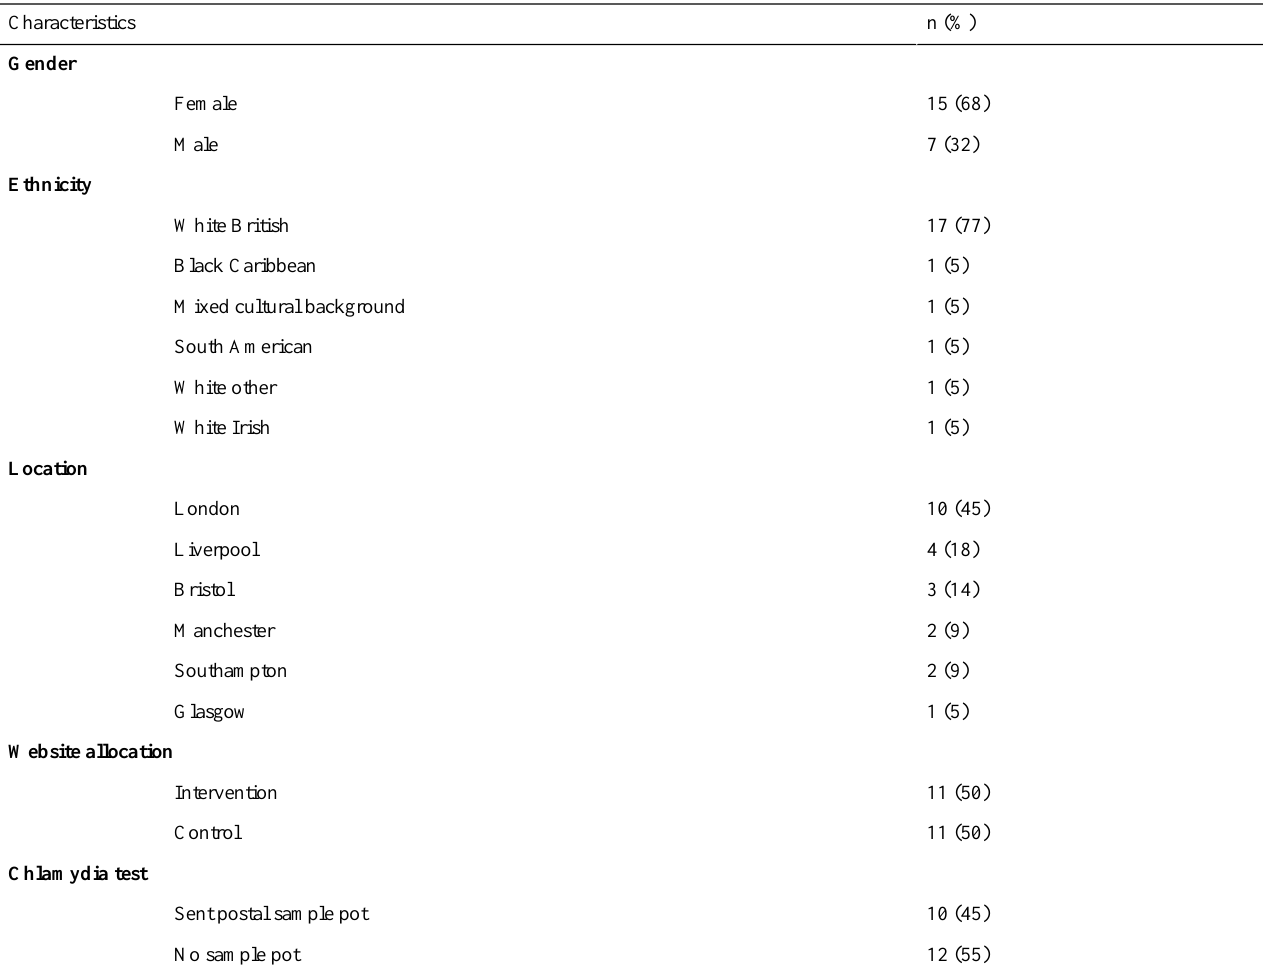
Table 1. Interview participant demographic characteristics